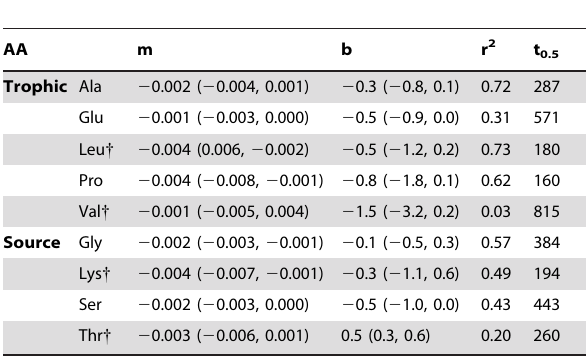
Essential amino acids are indicated by { .